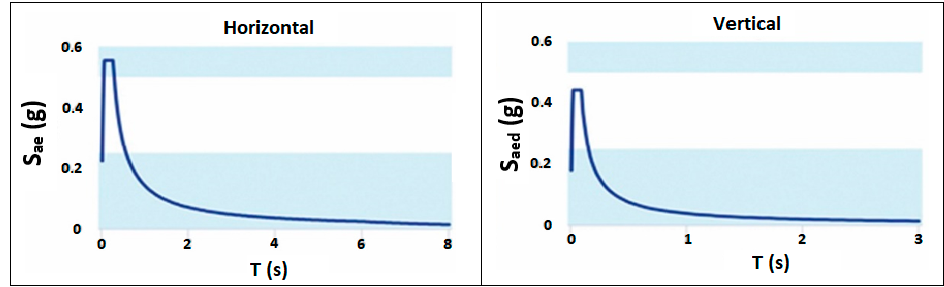
Figure 7. Horizontal and vertical design spectra obtained for the minaret of the Ulu Mosque.